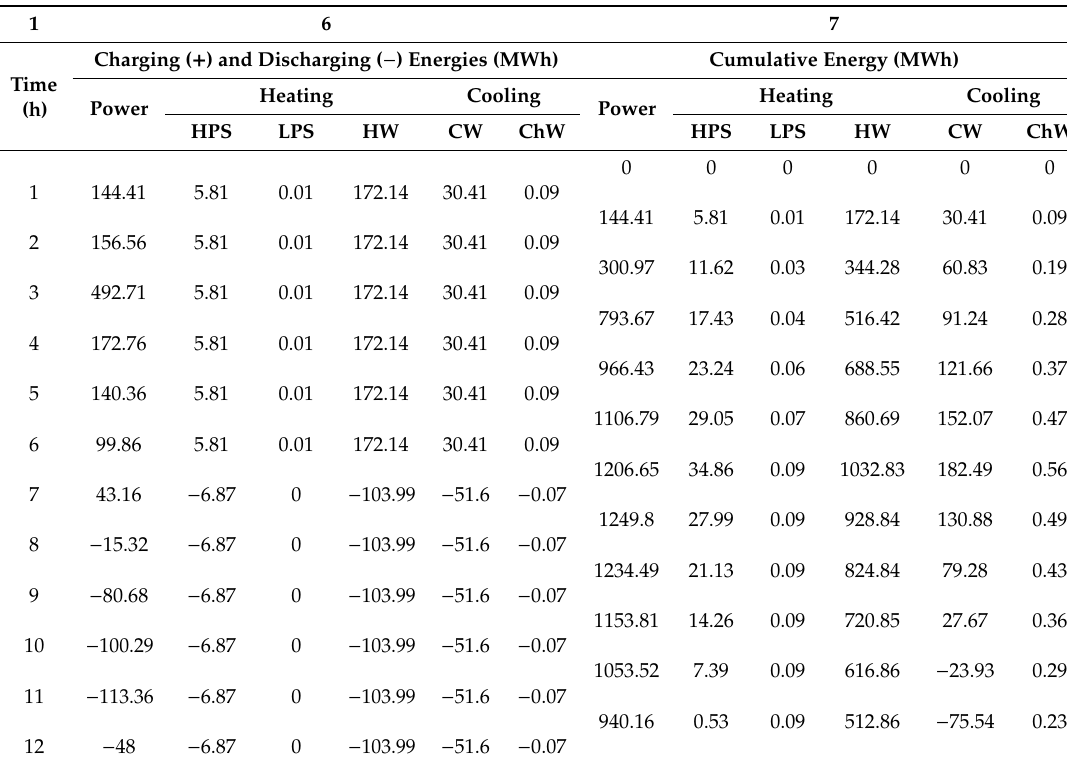
Table A13. TriGenSCA after iteration from time 1 to 12 h.